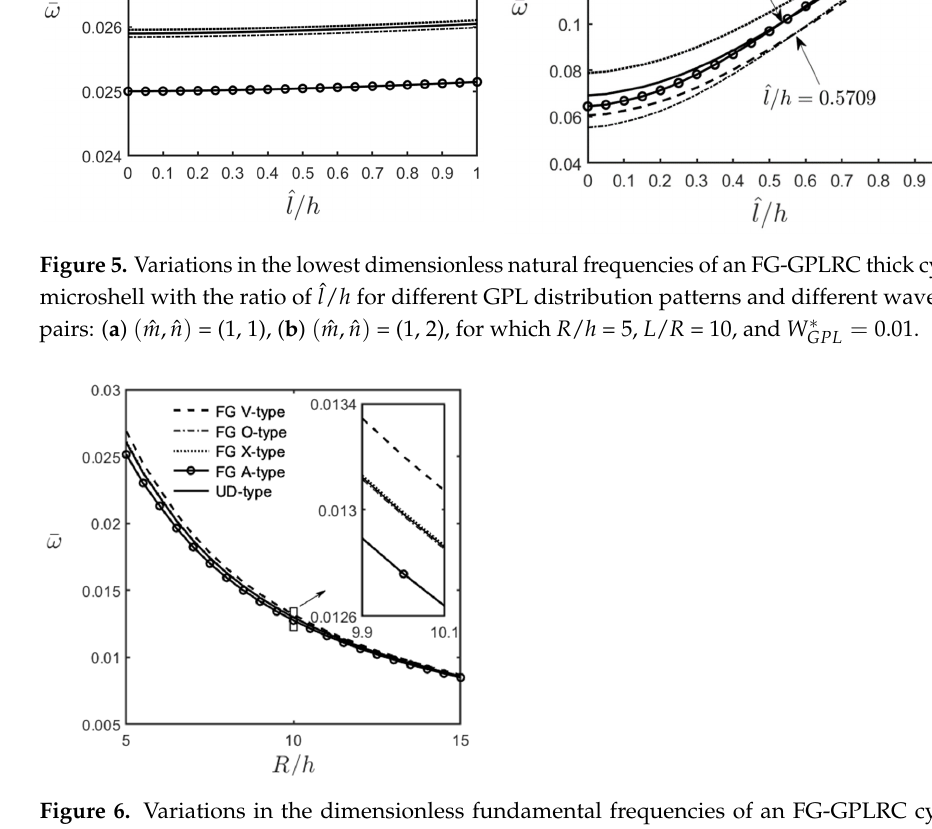
Figure 6. Variations in the dimensionless fundamental frequencies of an FG-GPLRC cylindrical microshell with the ratio of R / h for different GPL distribution patterns, for which ( ˆ m , ˆ n ) = (1, 1), L / R = 10, ˆ l / h = 1.0, and W ∗ GPL